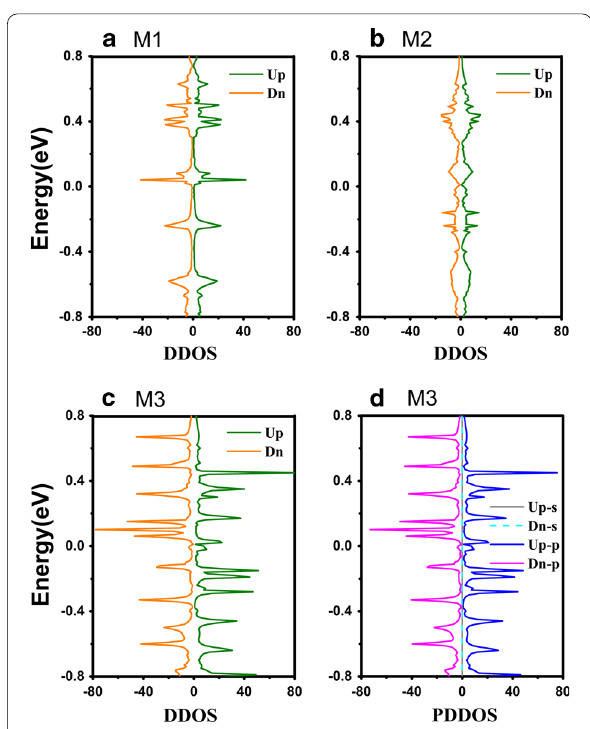
Fig. 5 (Color online) The DDOS is displayed as a M1, b M2 and c M3, respectively. d is the projected device density of states (PDDOS) for M3. The "Up-s" and "Dn-s" stand for the s- orbital PDDOS in spin-up and -down direction, the "Up-p" and "Dn-p" stand for the p- orbital PDDOS in spin-up and -down direction,